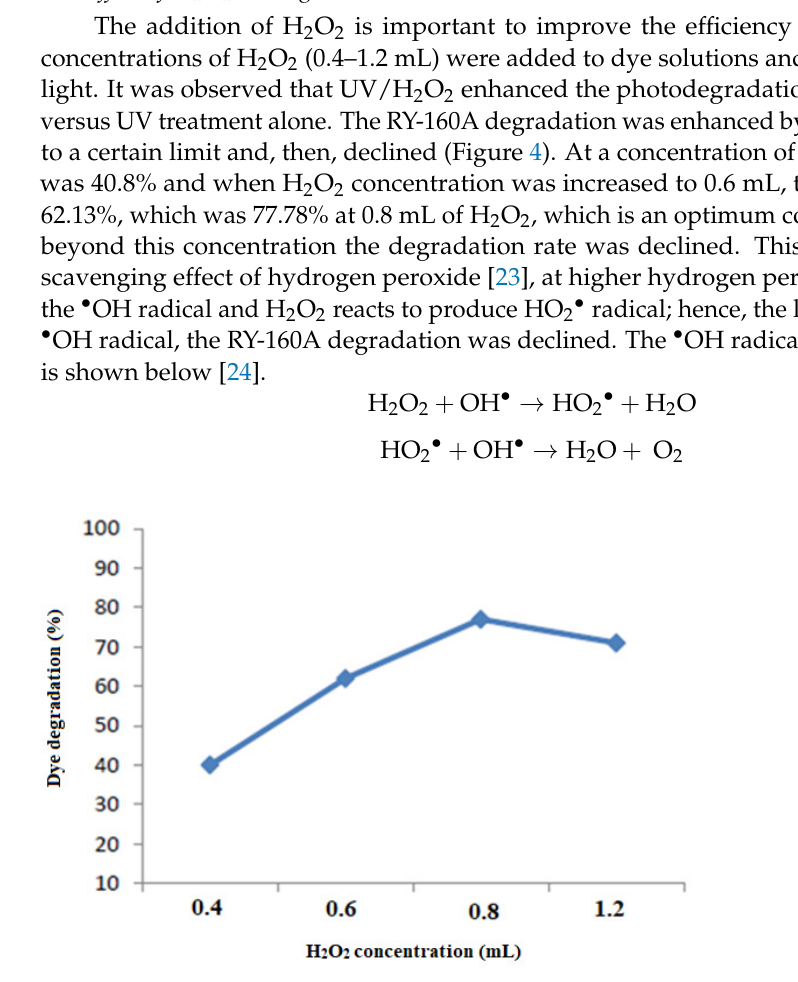
Figure 4. Effect of H 2 O 2 concentration on RY-160A degradation (pH = 3, RY-160A = 30 mg/L, irradiation time = 120 min).